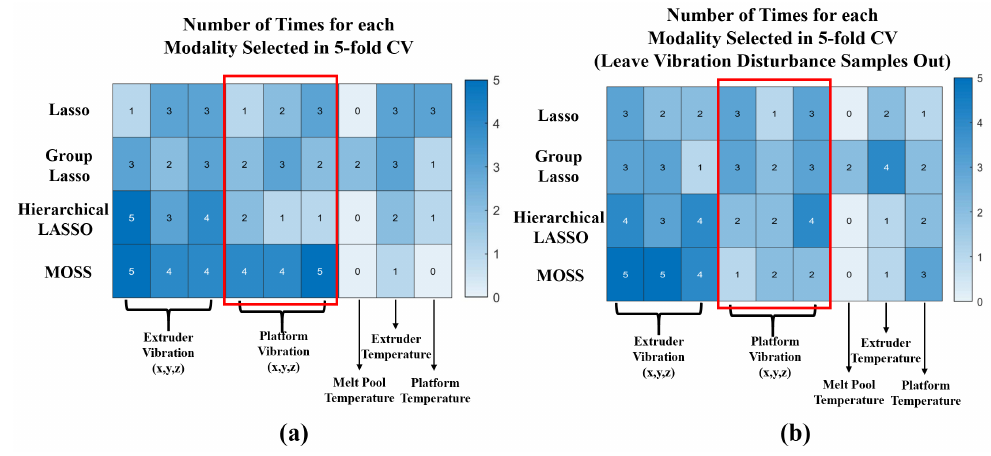
Figure 4. ( a ) Number of Times for each Modality Selected in 5-fold CV; ( b ) Number of Times for each Modality Selected in 5-fold CV after Leaving Vibration Disturbance Samples